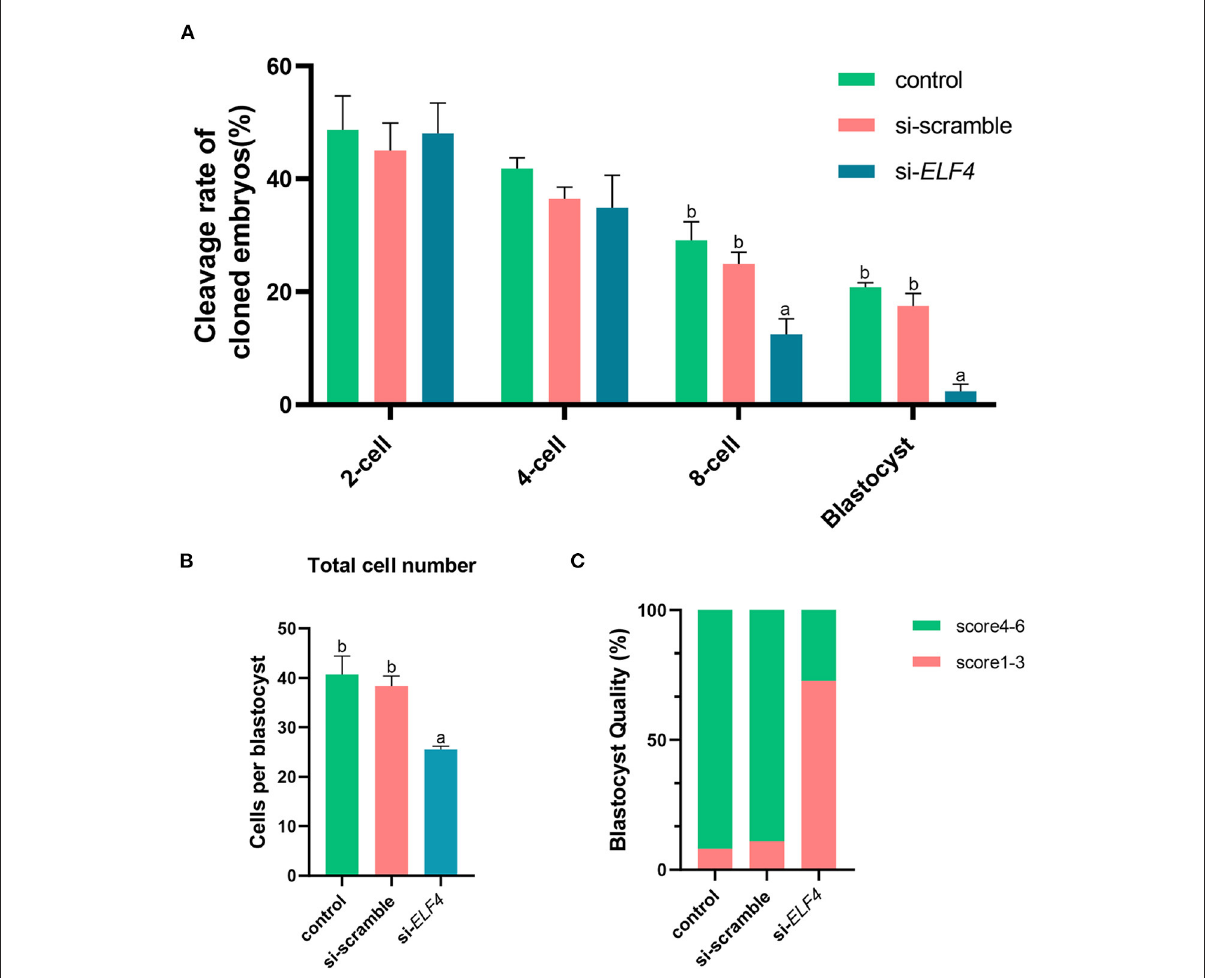
FIGURE4 Knockdown of ELF4 reduced blastocyst development rate and blastocyst quality in porcine IVF embryos. (A) The embryonic development capacity of control, si-scramble and si- ELF4 groups. (B,C) Blastocyst quality inspection: blastocyst cell count (B) , blastocyst grade (C) . Different lowercase letters indicate statistical differences ( p <